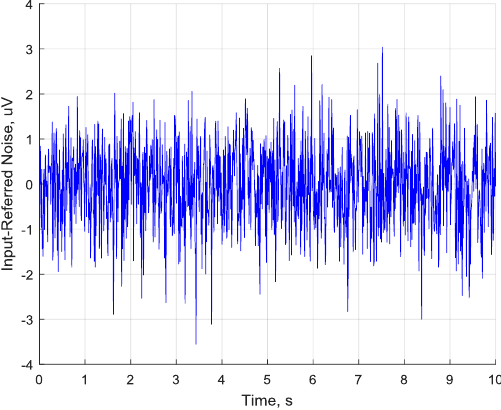
Figure 10. Single channel input-referred noise signal (F s = 1000 Hz, PGA = 3). Table 5. Average channel input-referred noise µV pp .